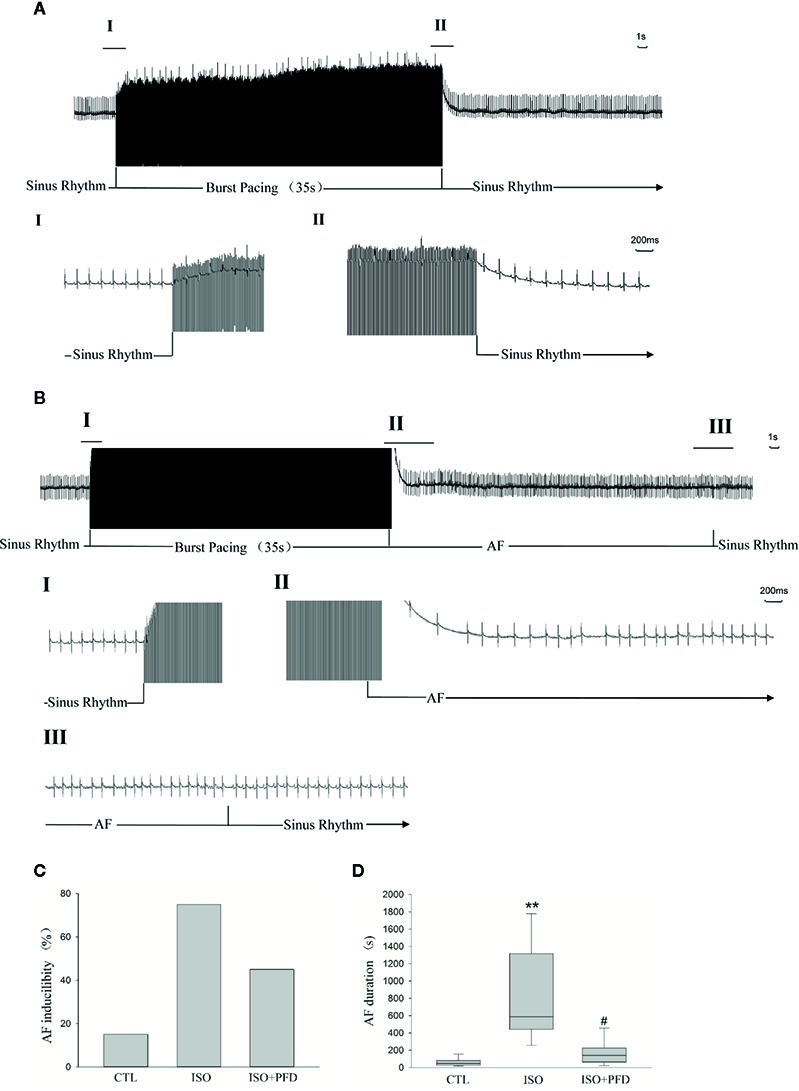
Isoproterenol (ISO) increases atrial fibrillation (AF) inducibility and duration in rats 5 weeks after injection. (A) Representative noninduced AF episode. After termination of the burst, the rat also displayed sinus rhythm (II). (B) Representative induced AF episode. Before the burst (I), the rat was in the sinus rhythm. After termination of the burst (II), the rat displayed an irregular atrial rhythm with an irregular ventricular response. After seconds (III), the AF episode stopped spontaneously and the sinus rhythm resumed. (C) ISO increases AF inducibility in rats (n=20 rats/group). (D) ISO increases AF duration (n=20 rats/group). **P < 0.01 versus control (CTL) group; #
P < 0.05 versus ISO group.